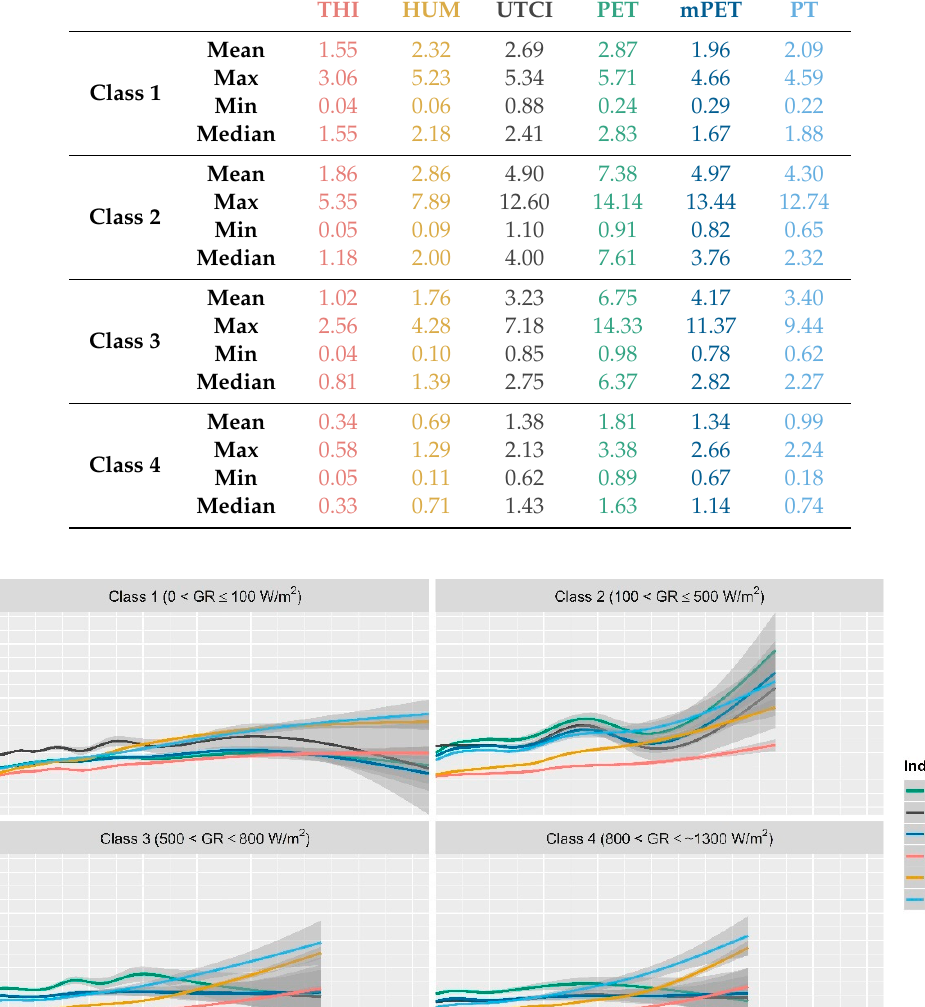
Table10. Descriptivestatisticsoftheindices’sensitivitytoT a changeratesunderdi ff erentGRconditions.